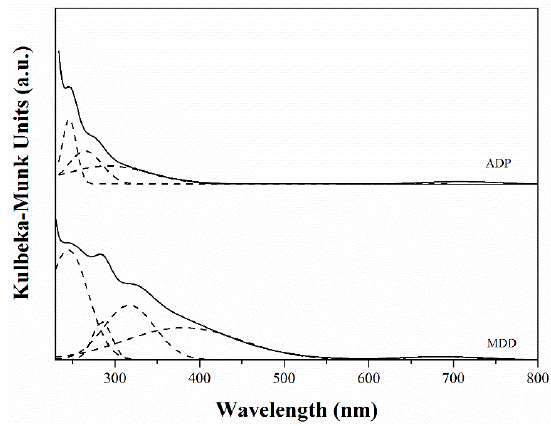
Figure 5. UV–Vis diffuse reflectance spectra of Cu/SBA ‐ 15 materials prepared by ADP method (top) and MDD method